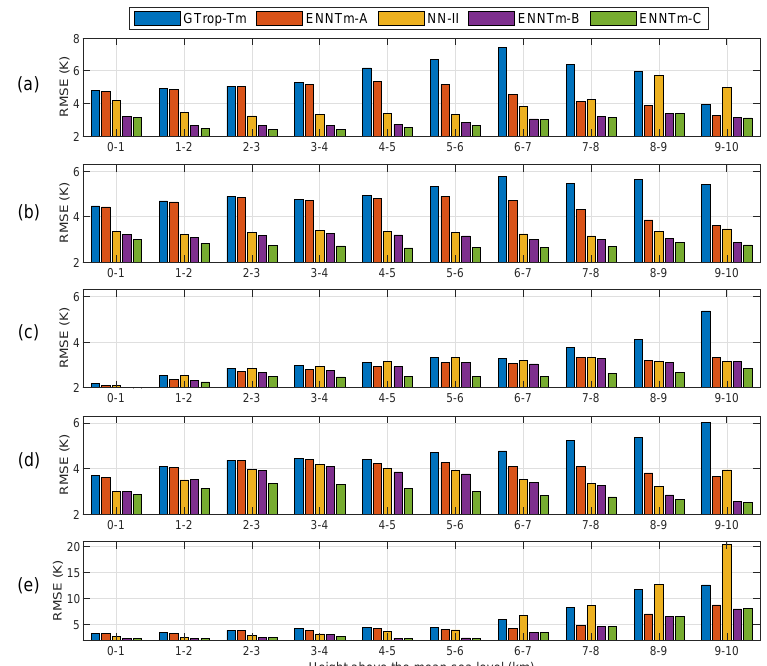
Figure 12. The statistics of RMSEs at different height layers in the ( a ) NFZ; ( b ) NTZ; ( c ) TZ; ( d ) STZ; and ( e )